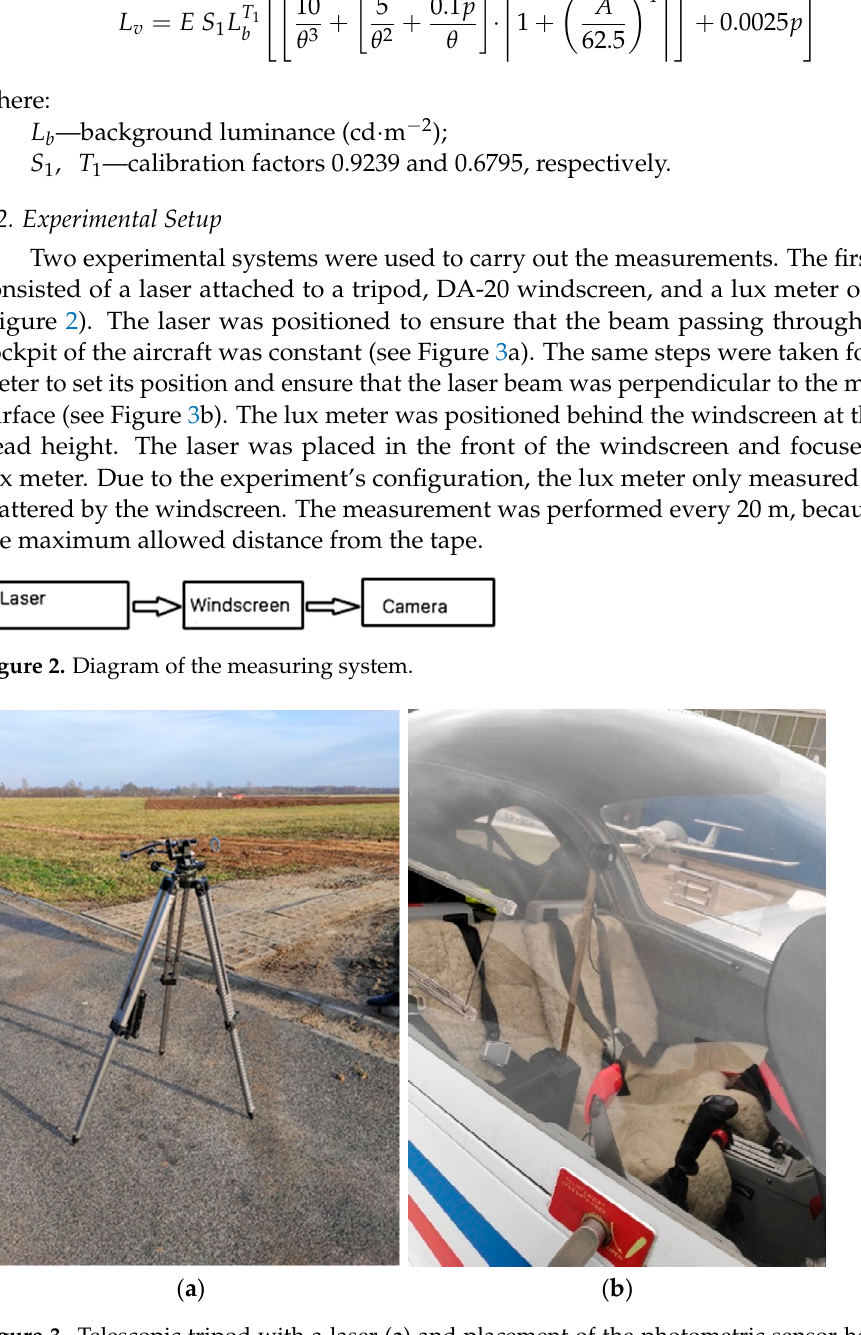
Table 2. Comparison of laser parameters.